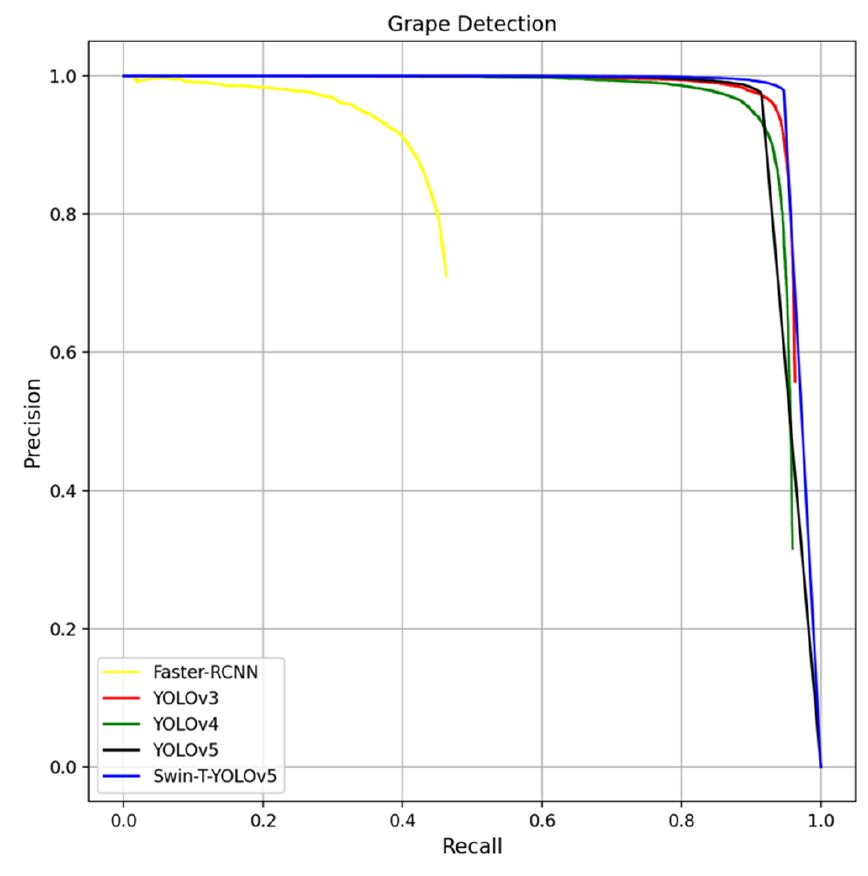
Figure 5. Precision–recall (P–R) curves of Faster R-CNN, YOLOv3, YOLOv4, YOLOv5, and Swin- transformer-YOLOv5 (Swin-T-YOLOv5) in detecting grape bunches.